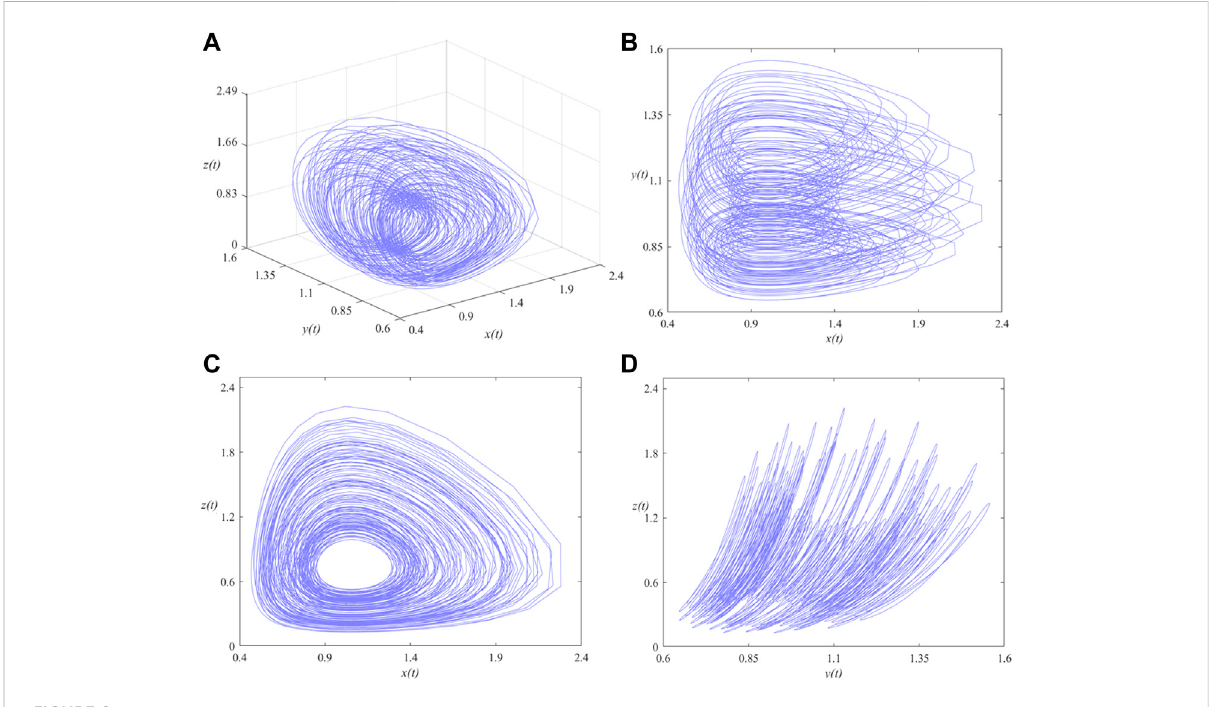
FIGURE 2 Phase portraits of the SMFrLVS when α i (i = 1, 2, 3) = 0.8 in: (A) x-y-z space, (B) x-y, (C) x-z, (D) y-z